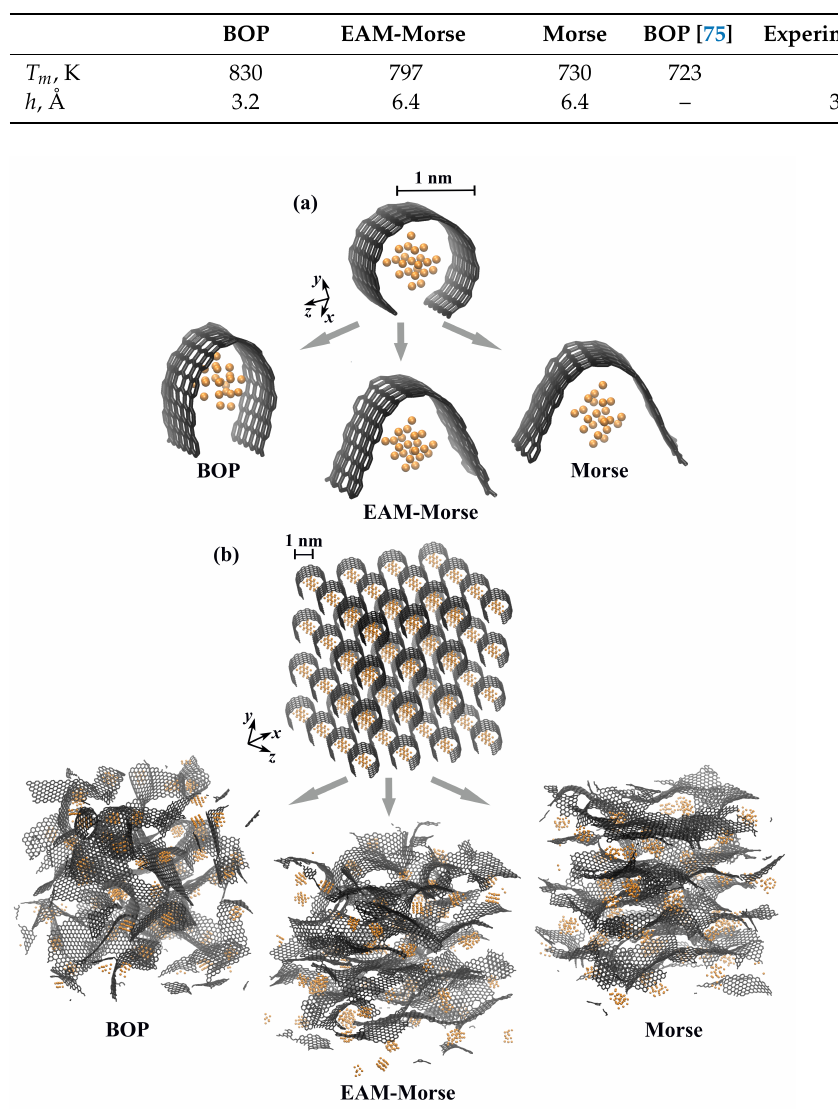
Figure 1. ( a ) Graphene flake with Cu nanoparticle inside and ( b ) composite precursor at the initial state and after exposure at 300 K. Cu atoms are shown in orange and C atoms are shown in black